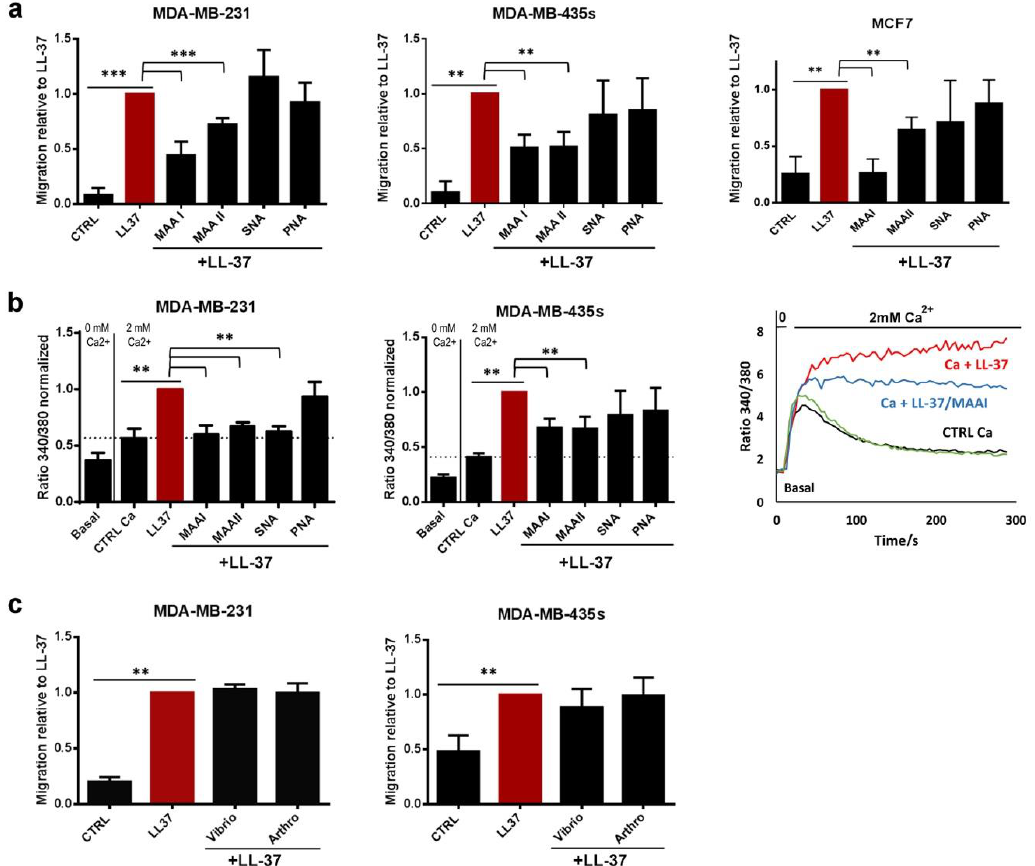
Figure 1. LL-37-induced migration and calcium entry is suppressed by lectins but not by removal of sialic acids. ( a ) Migration of MDA-MB-231, MDA-MB-435s and MCF7 induced by LL-37 (10 µ g / mL) with or without lectins (5 µ g / mL), MAA I and MAA II ( Maackia amurensis I and II), SNA ( Sambucus nigra Agglutinin) and PNA (Peanut Agglutinin) (N = 8, 6 or 3). ( b ) Calcium entry in MDA-MB-231 and MDA-MB-435s (N = 4) at conditions as in ( a ). To the right, a display of the time course of fura-2 fluorescence ratio detected at 510 nm with both excitations at 340 and 380 nm is shown. The graph to the right shows representative curves for the time course of the fura-2 fluorescence ratio at 510 nm with excitations at 340 and 380 nm. ( c ) Migration of MDA-MB-231 and MDA-MB-435s induced by LL-37 (10 µ g / mL) after treatment with sialidases of Arthrobacter ureafaciens or Vibrio cholerae (treatment at 0.1 UI / mL for 1 h) that preferentially digested α 2–6 and α 2–3 sialic acids, respectively (N = 4). Data (migration and calcium entry) were normalized to the e ff ect of LL-37. Statistics are relative to control without LL-37, with *** p < 0.001, ** p < 0.01, * p < 0.05, and relative to the e ff ect by